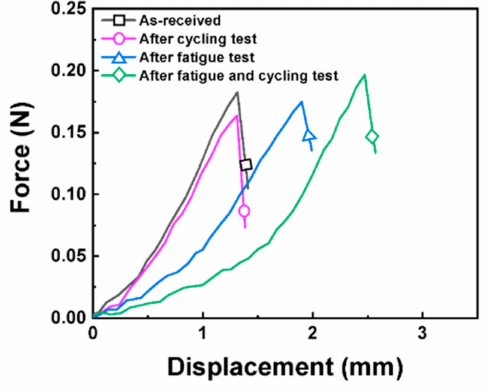
Figure 10. Force and displacement curves as a result of the puncturing test on the separators in the cells under various test